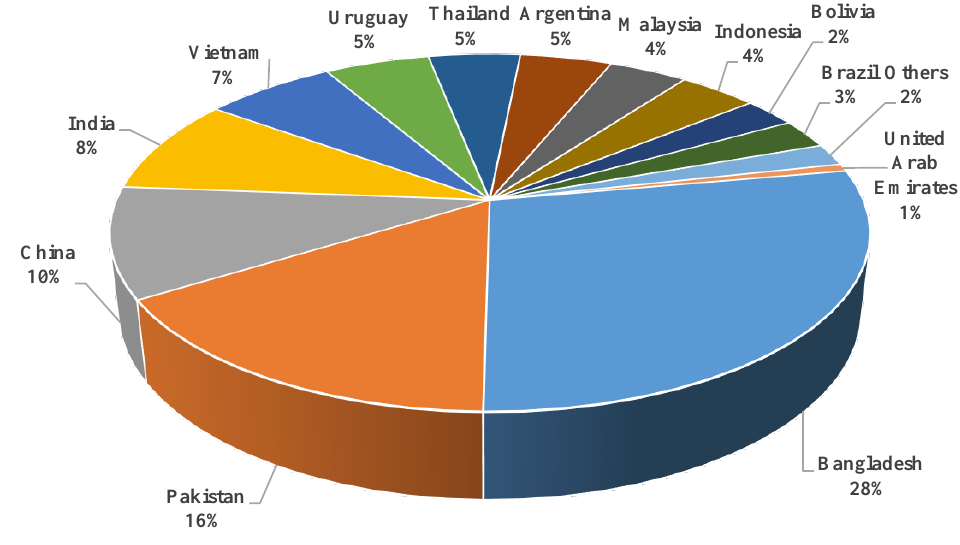
Figure 1. Presence of X. citri in the world by country in 2018.